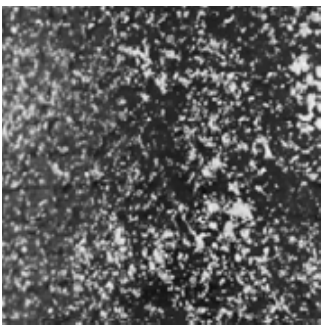
Figure 7. Particle texture on the specimen.